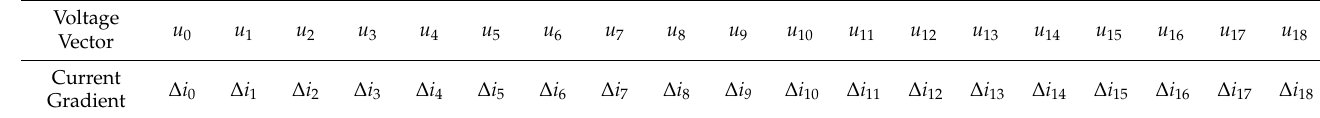
Table 1. The LUT of the T-type three-level